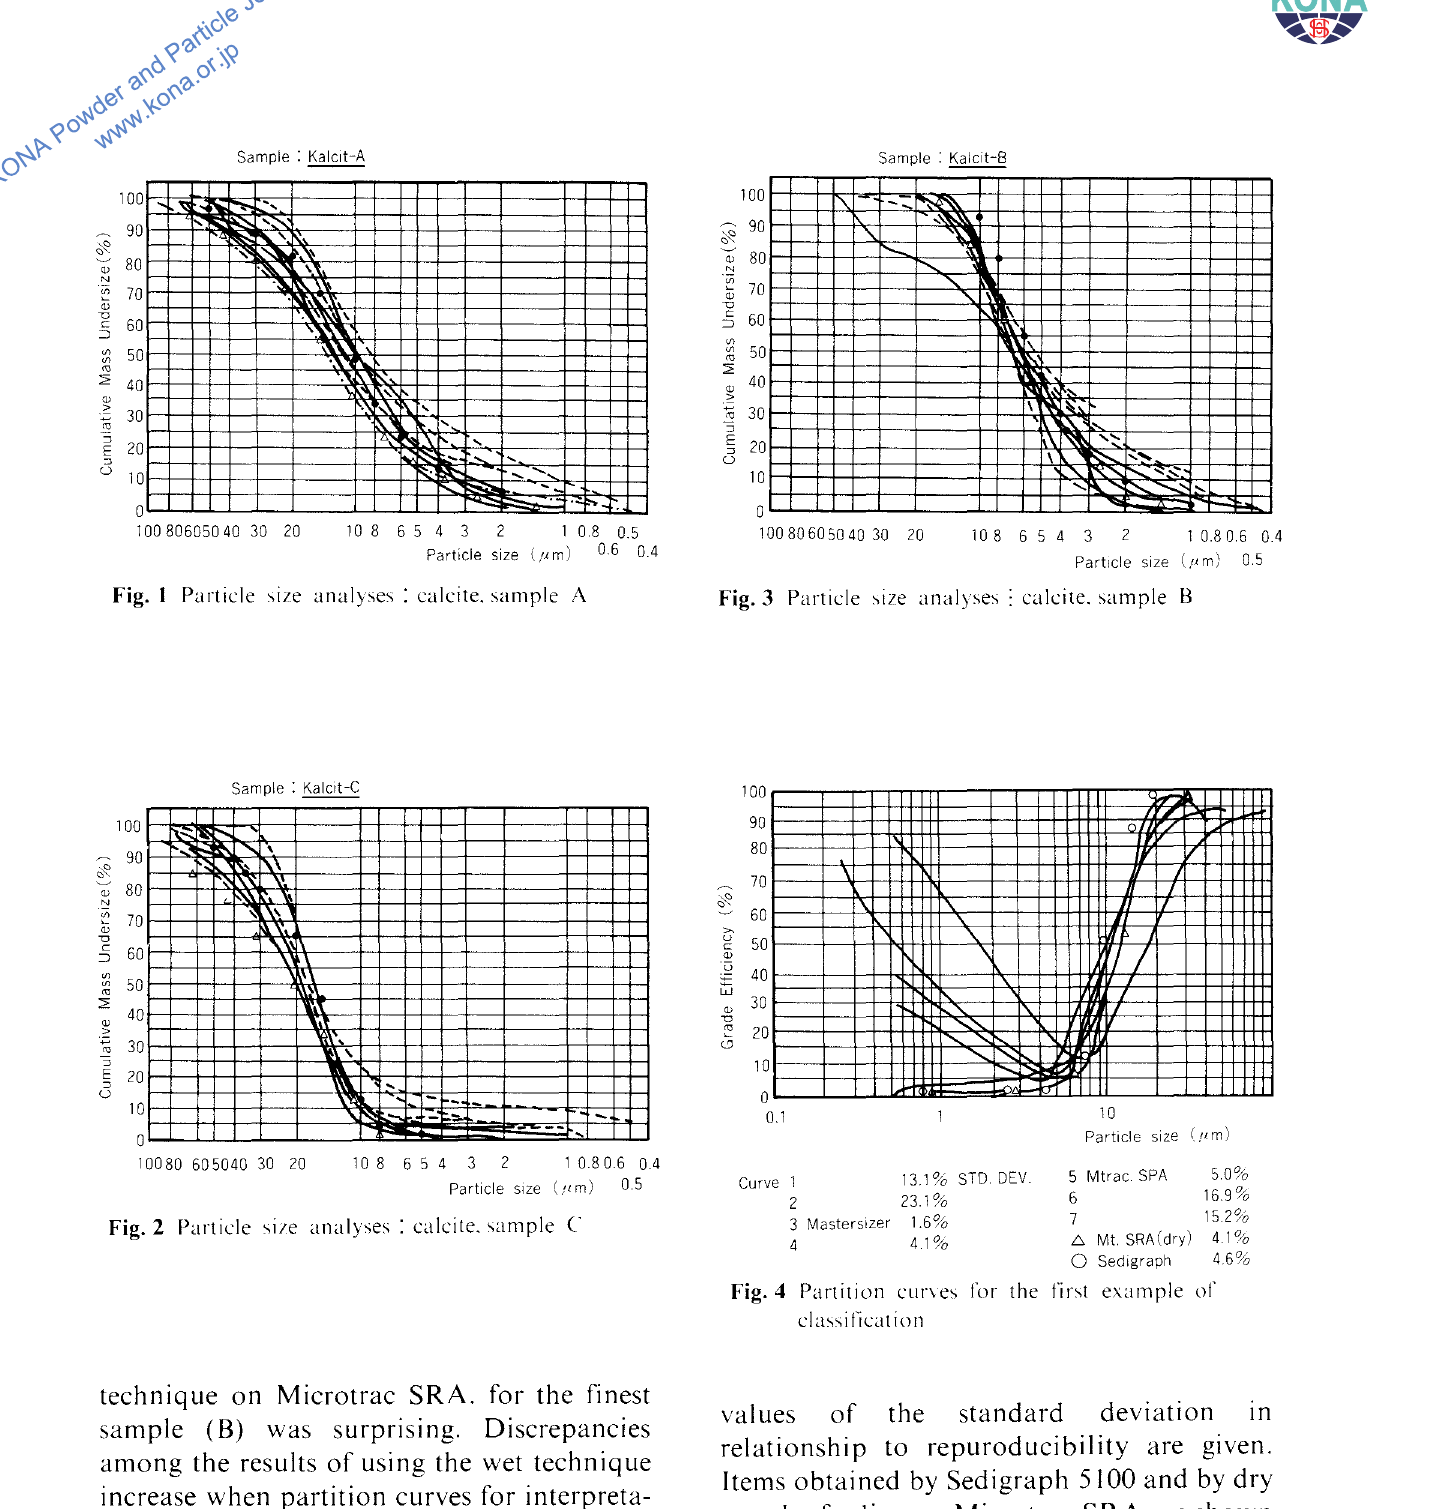
Fig. 4 Partition cuneo, for the fir">t example of cJa,sification values of the standard deviation m relationship to repuroducibility are given. Items obtained by Sedigraph 5100 and by dry powder feeding on Microtrac SRA are shown in Fig.4. The same diagram also shown in clearly indicates that the accuracy and re producibility of the process description are not